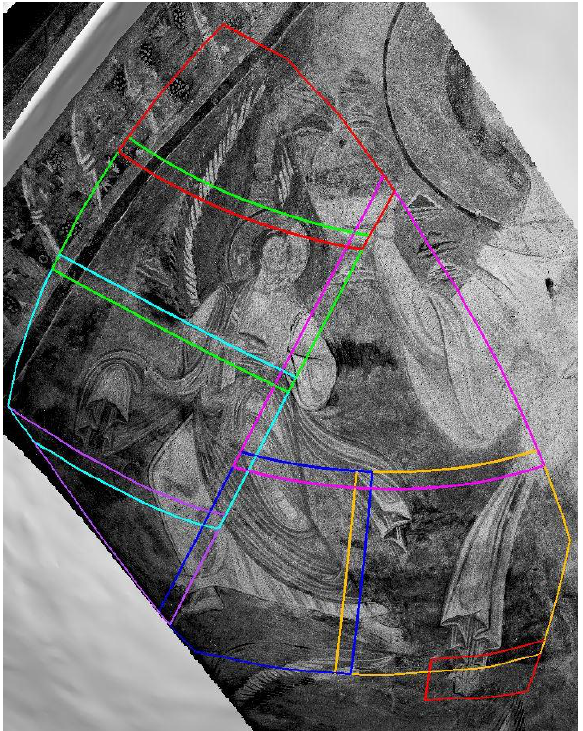
Figure 9. Segmentation of the texturized mesh in eight parts (angel on the right side of the Pantocrator Christ).